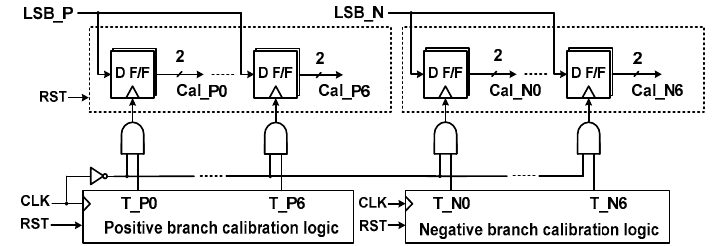
Figure 14. Schematic of the register for storing the calibration data.